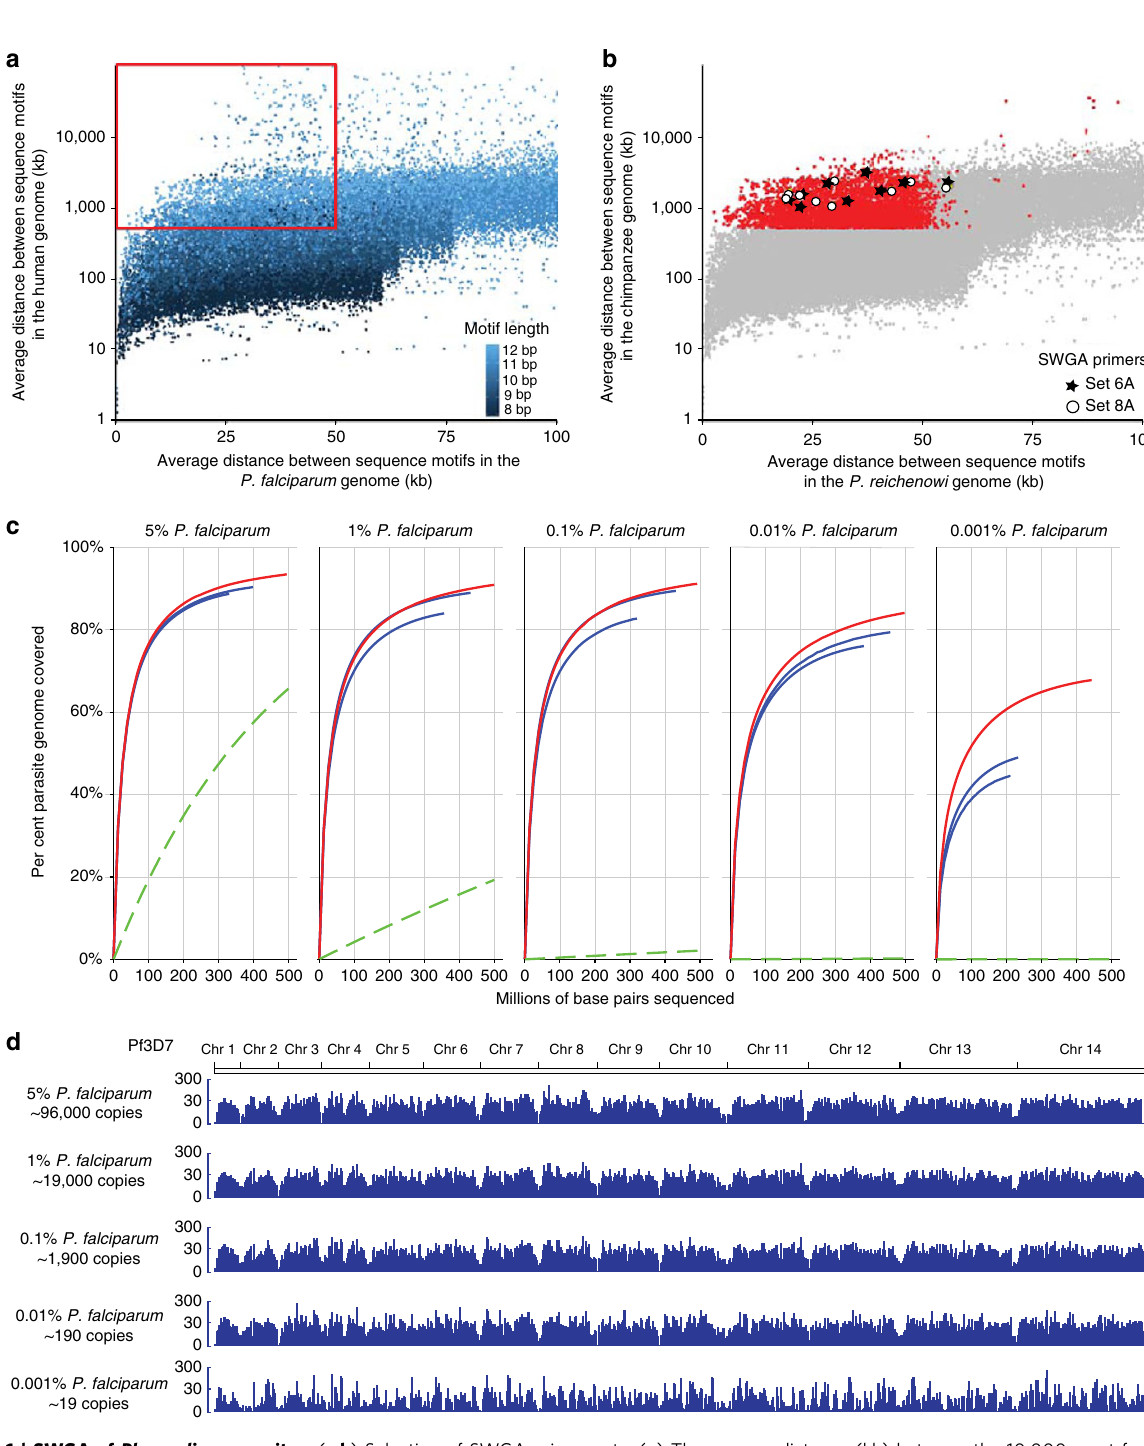
Figure 1 | SWGA of Plasmodium parasites. ( a , b ) Selection of SWGA primer sets. ( a ) The average distance (kb) between the 10,000 most frequent parasite motifs (colour coded by length) is plotted for both the P. falciparum (Pf3D7) and human (GRCh37) genomes. The red box highlights motifs that are spaced (on average) o 50,000bp apart in the P. falciparum , but 4 500,000bp apart in the human genome. ( b ) Average distances between the sequence motifs shown in a , but plotted for the P. reichenowi (PrCDC) and chimpanzee (Pan_troglodytes-2.1.4) genomes. Red dots indicate all motifs that fall within the red box in a , with circles and stars denoting those selected for SWGA primer sets 6A and 8A, respectively (Supplementary Fig. 1). ( c ) Validation of the SWGA primer sets. Human genomic DNA spiked with known quantities of P. falciparum DNA (5–0.001%) was subjected to consecutive rounds of SWGA, using primer set 6A in the first and primer set 8A in the second round. The number of total base pairs (in millions) sequenced is shown in relation to the per cent coverage of the P. falciparum (Pf3D7) genome for five parasite concentrations. DNA mixtures were subjected to two independent amplifications, with individual and combined results shown in blue and red, respectively (the expected genome coverage without SWGA is shown in green). ( d ) MiSeq read depth for all 14 chromosomes across the Pf3D7 genome shown for one representative amplification at each of five parasite concentrations (individual chromosomes are drawn to scale as indicated on top). For each parasite/human DNA mixture, the percentage of P. falciparum and estimated number of genome copies are indicated. An expanded view of coverage across chromosome 9 is shown in Supplementary Fig.